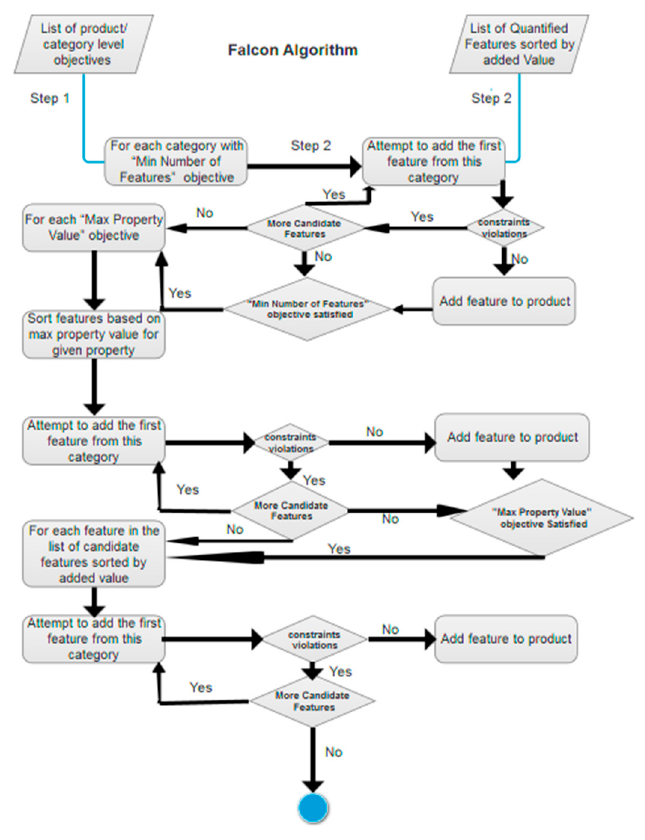
Figure 2. The Falcon features Selection Algorithm.